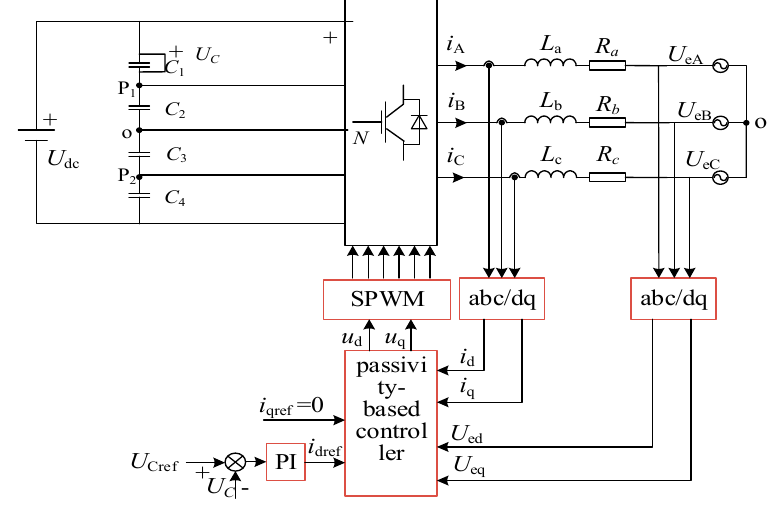
Figure 3. The block diagram of the system.